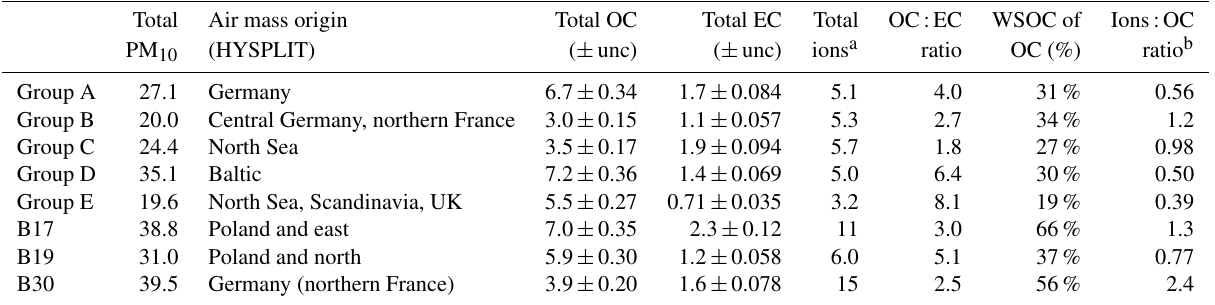
Table 3. Basic bulk composition results, ratios, and air mass origin from HYSPLIT. Units are µgm − 3 unless otherwise noted. For OC and EC measurement uncertainty is included.